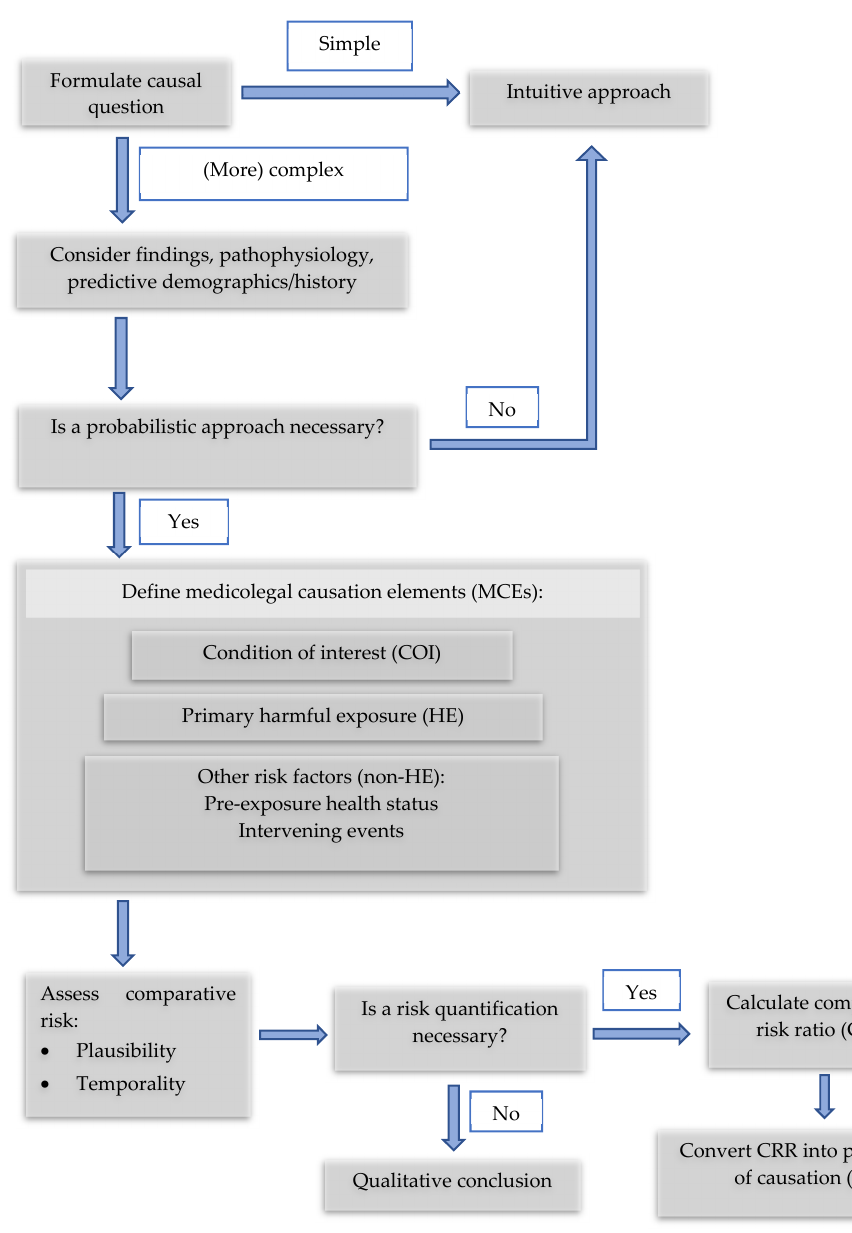
Figure 1. Flowchart of the INFERENCE approach [17].